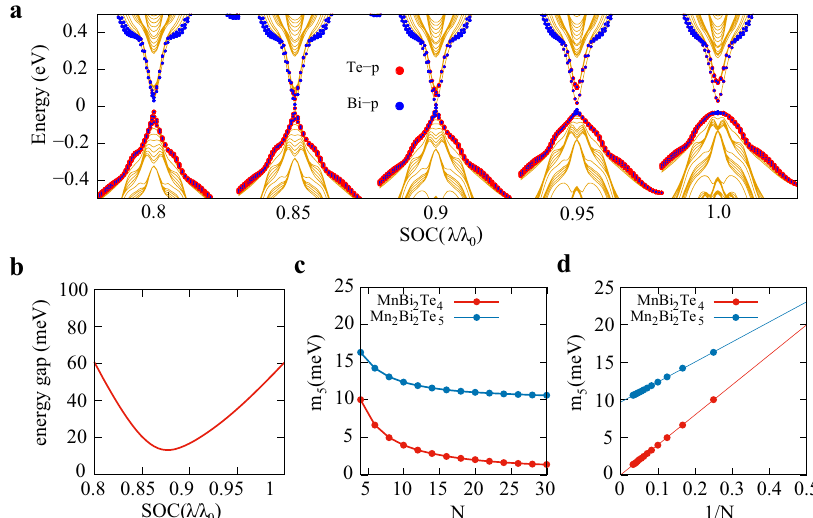
Fig. 2 Finite-size effect of MnBi 2 Te 4 thin fi lms. a The evolution of the band structure of the 12-SL MnBi 2 Te 4 thin fi lm as a function of the strength of the SOC λ / λ 0 . b The evolution of the energy gap with the SOC strength. The energy gap fi rst goes smaller and then goes larger without exactly closing. It is clear to see a minimum energy gap when increasing the SOC, which corresponds to 2 ∣ m 5 ∣ (the P , S -breaking mass). c,d The mass m 5 versus the thickness of MnBi 2 Te 4 (red) and Mn 2 Bi 2 Te 5 (blue) thin fi lms. N presents the number of bi-SLs of MnBi 2 Te 4 fi lms or (nonuple layers)NLs of Mn fi 2 Bi 2 Te 5